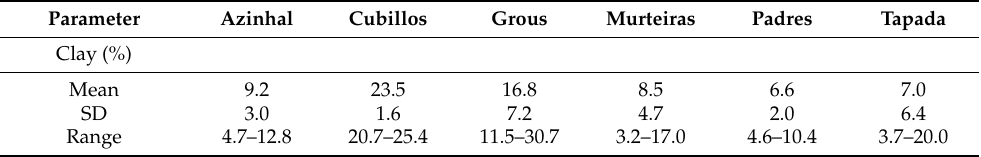
Table 4. Descriptive statistics (mean, standard deviation and range) of the soil parameters in each of the six experimental fields used in this